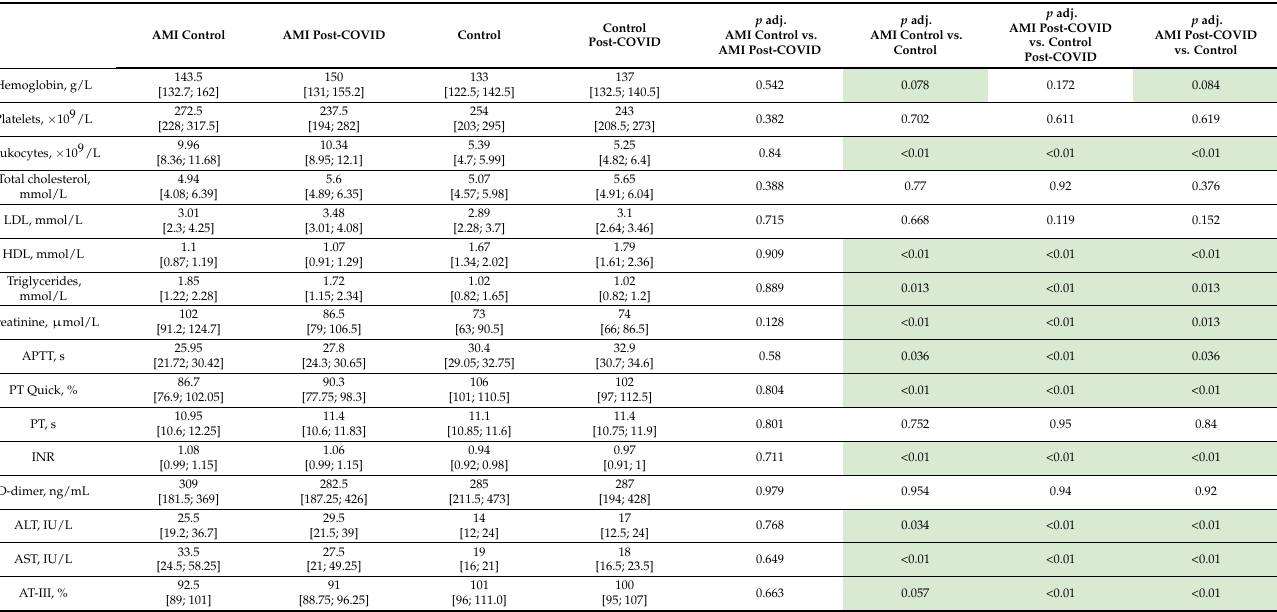
Table 2. Comparison of laboratory data between study groups. LDL—low-density lipoproteins, HDL—high-density lipoproteins, APTT—activated partial thromboplastin time, PT Quick—Quick prothrombin time test, PT—prothrombin time, INR—international normalized ratio, ALT—alanine aminotransferase, AST—aspartate aminotransferase, AT-III—antithrombin III. Green: p adj. < 0.1. Data are presented as the median [Q1;